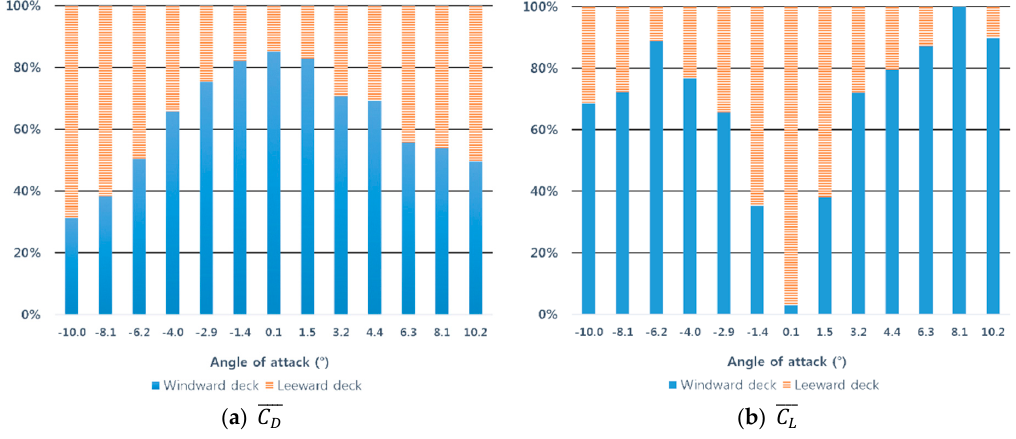
Figure 14. Relative contribution of each deck to the mean force coe ffi cients (( a ) C D and ( b ) C L ) AoA. versus